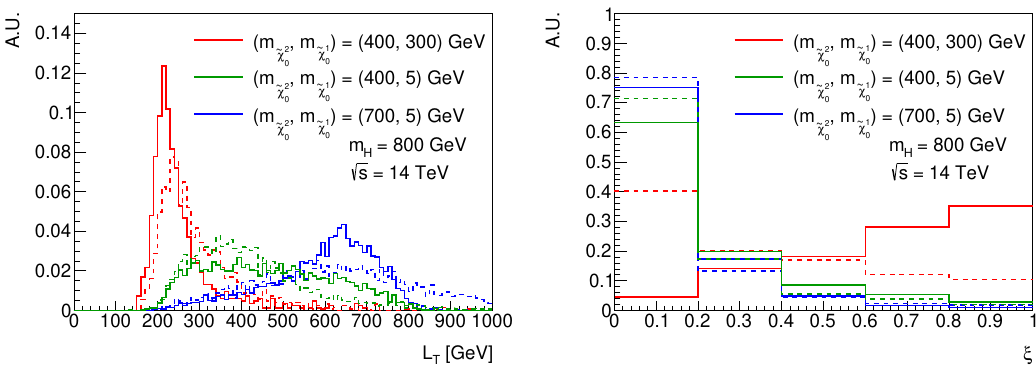
Figure 11. Normalised distributions for L T of the events with preselections as defined in the text (left) and ξ (right) for three different benchmark points. The dashed lines represent production via SM mediated processes and the solid lines represent production via heavy Higgs